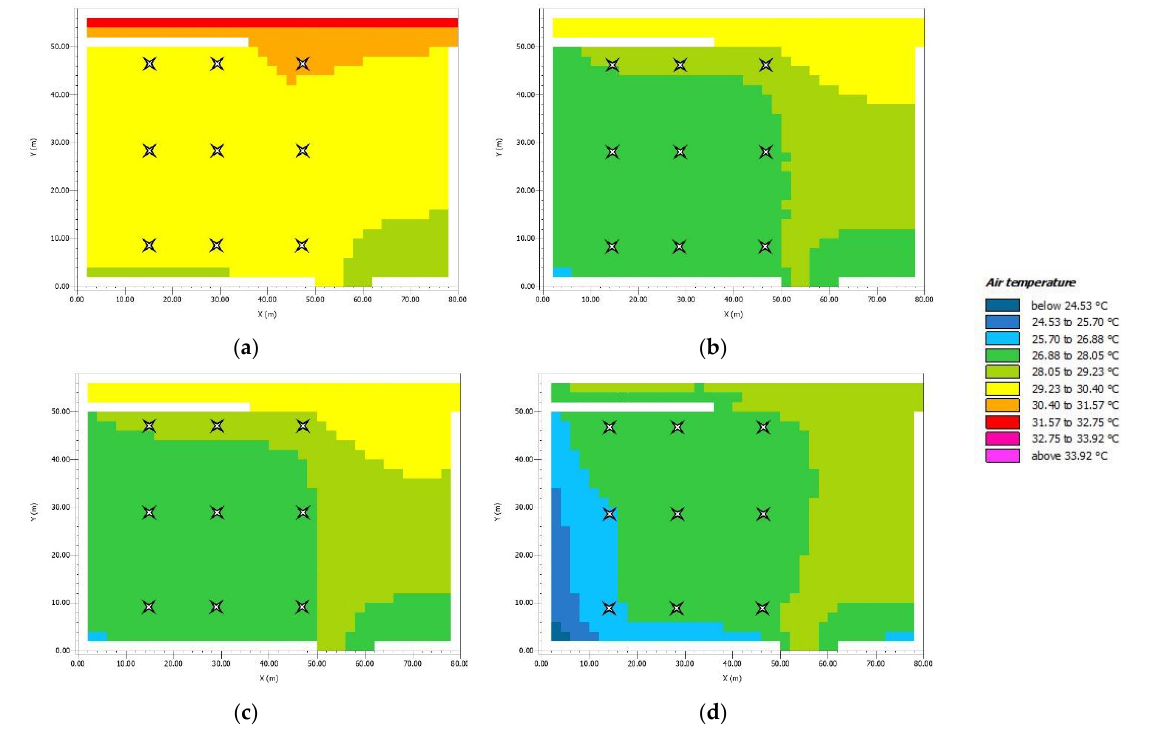
Figure 7. AT at 12.00 a.m. in July. ( a ) AS; ( b ) LC+G1; ( c ) LC+G2; ( d ) LC+G3. Figure 7. AT at 12:00 a.m. in July. ( a ) AS; ( b ) LC+G1; ( c ) LC+G2; ( d ) LC+G3.